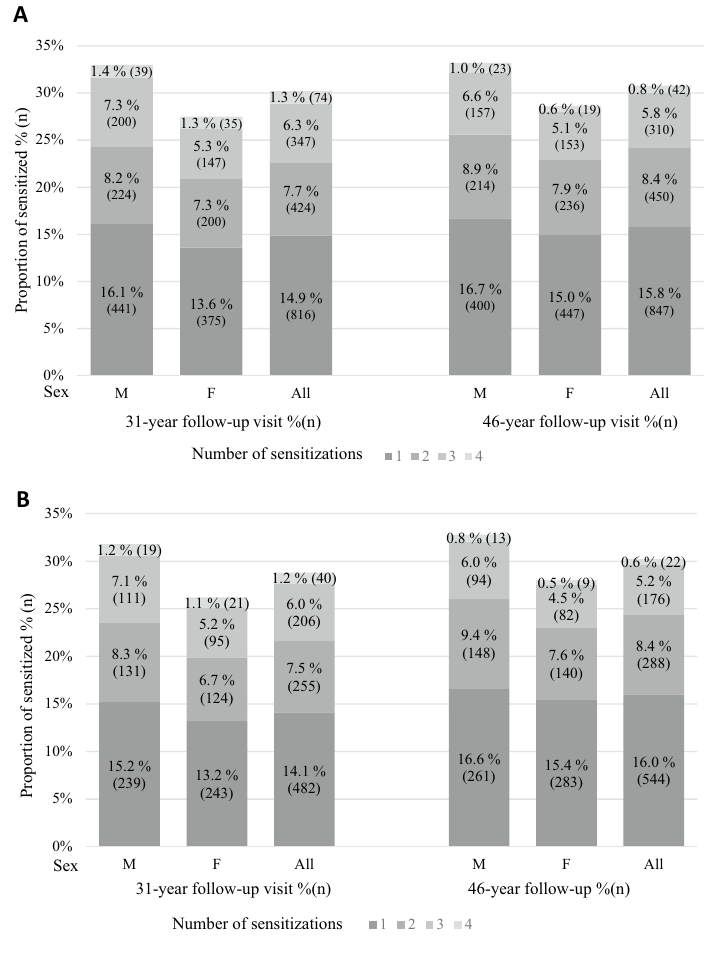
Figure 1. Prevalence of sensitization and polysensitization by sex at the 31- and 46-year follow-up visit. ( A ) All study subjects, ( B ) Longitudinal sub-population. P < 0.001 for polysensitization between sexes in both settings in both time points. Shades of gray representing amounts of sensitizations : (1) one sensitization, (2) two sensitizations, (3) three sensitizations, (4) four